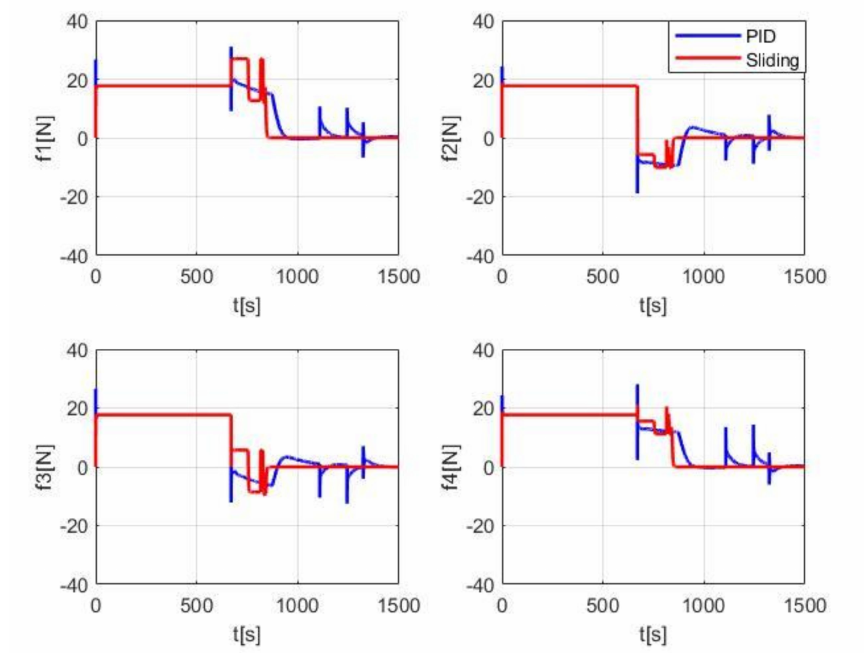
Figure 14. Time history of the in-plane thrust generated by each thruster of the